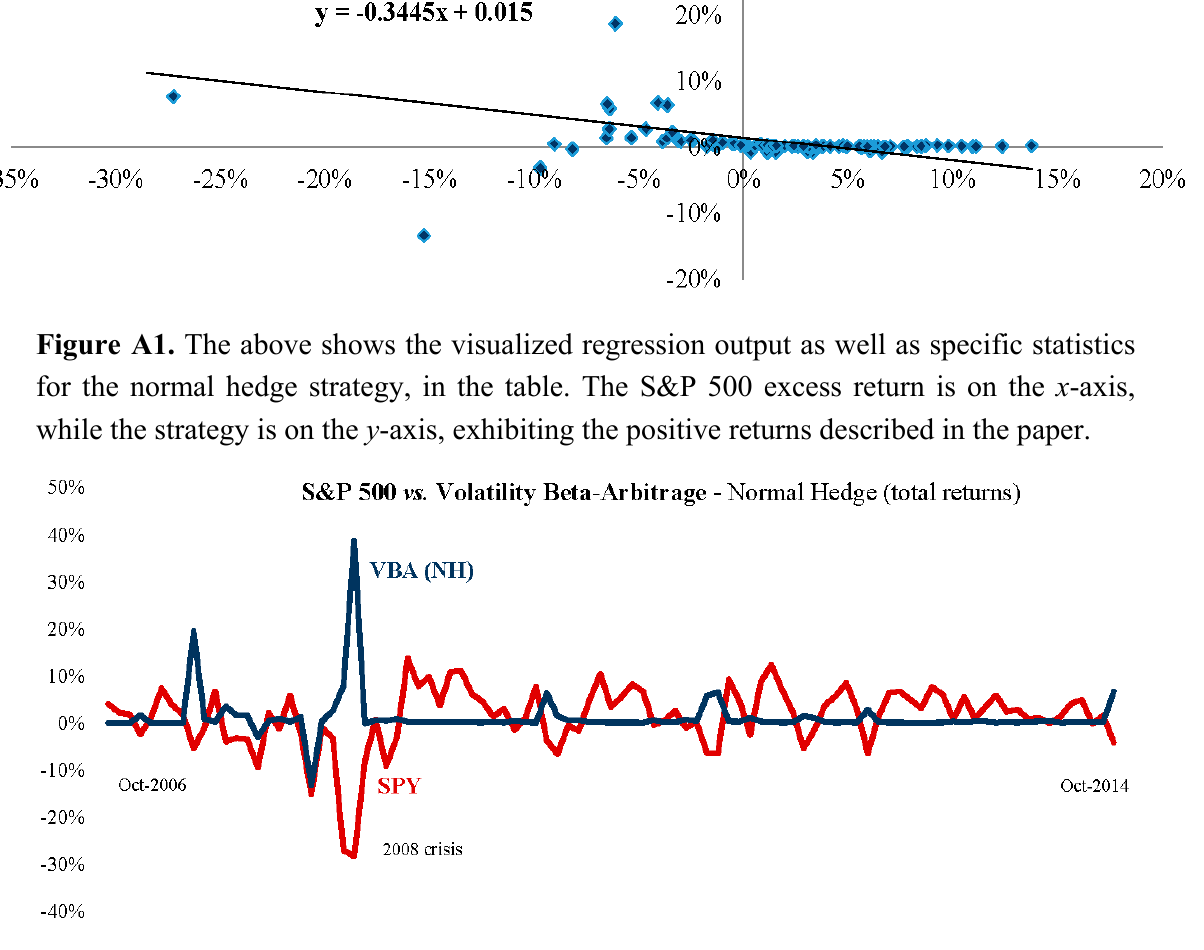
Figure A2. Note how the strategy gives a general counteraction to the dips in the benchmark, right up until the latest dip in